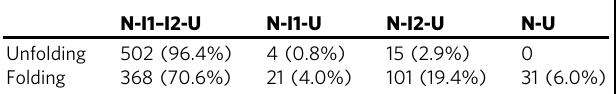
Fig. 4 Mechanical unfolding/folding of RTX-iv-T1411C-v. a Schematics of stretching RTX-iv-T1411C-v from the C-terminus and T1411C (indicated by the green asterisk). b Representative F – D curves of RTX-iv-T1411C-v, in which the molecule was stretched to unfold – fold RTX-iv-T1411C only. The unfolding and folding patterns are the same as those of wt RTX-iv. c Force – extension relationships of the unfolding of RTX-iv-T1411C. The WLC fi ts yielded a Δ Lc1 ( n = 57, N-I1) of 6.1 ± 0.4 nm, Δ Lc2 ( n = 52, I1 – I2) of 11.0 ± 0.5 nm, Δ Lc3 ( n = 64, I2-U) of 23.1 ± 0.6 nm and Δ Lc ( n = 30, RTX-iv-T1411C) of 39.7 ± 0.8 nm. The error bars indicate standard deviations. Table 1 Numbers and percentage of each individual unfolding and folding pathway of